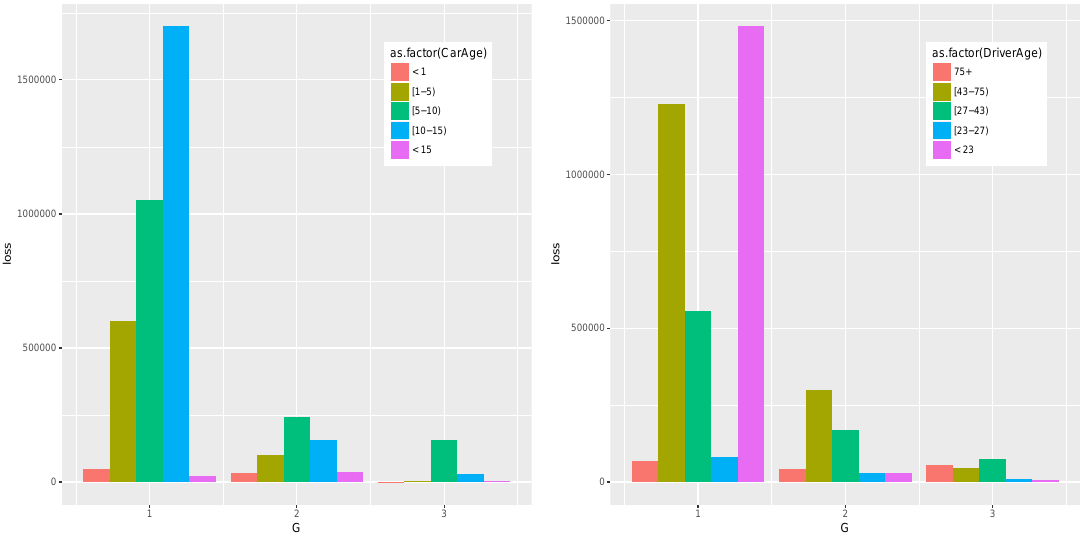
Figure 3. The bar plot ( left ) displays the profile of the losses in each cluster G = 1:3, by driver age. The bar plot ( right ) displays the profile of the losses in each cluster G = 1:3, by car